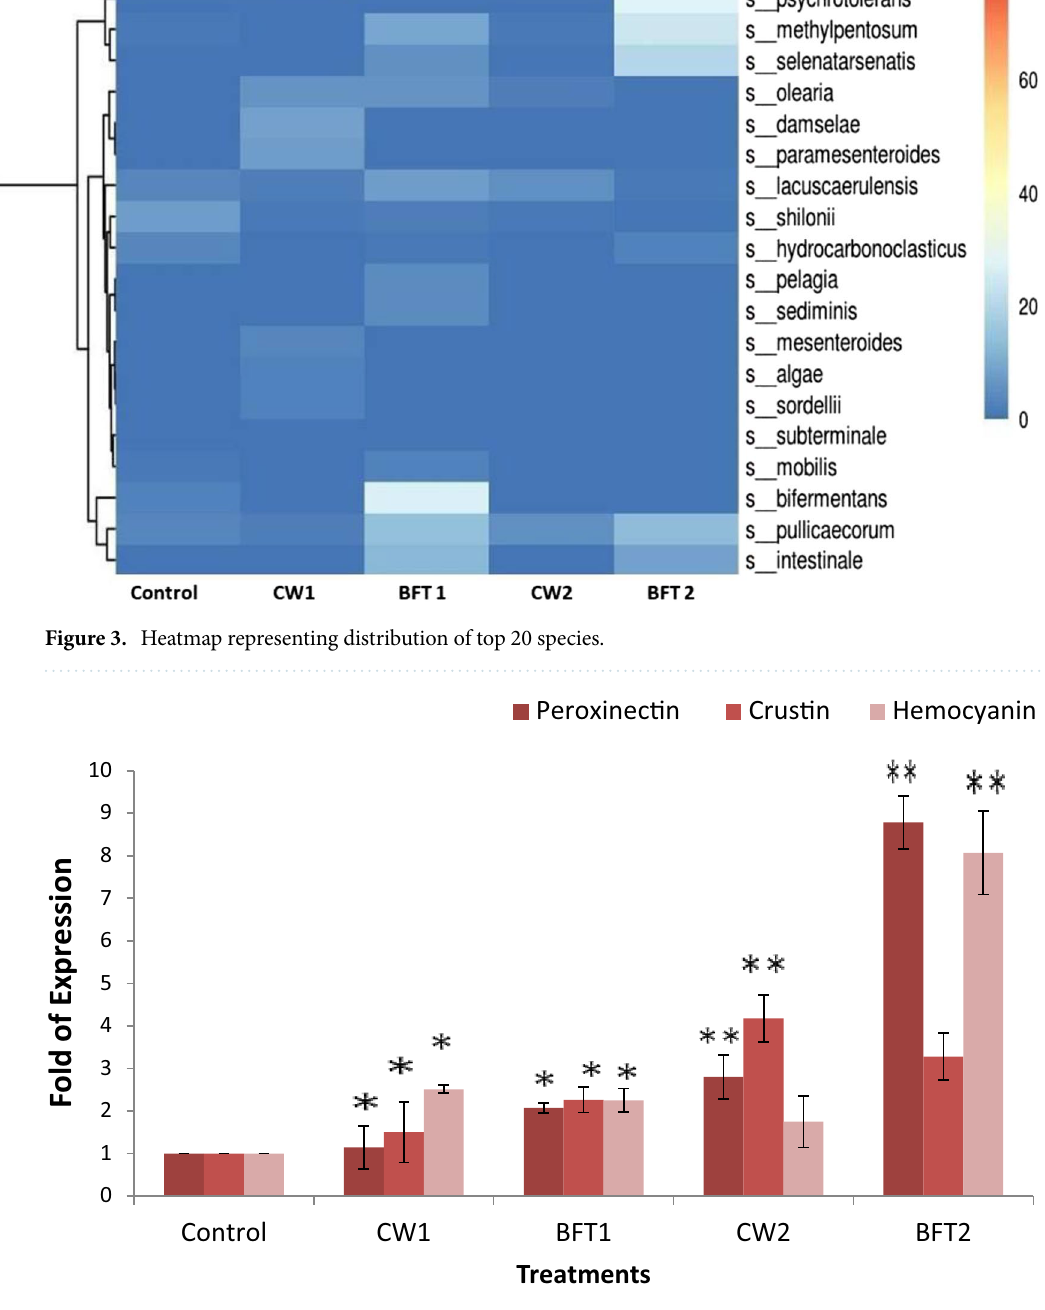
Figure 4. Relative expression of peroxinectin, crustin and hemocyanin of P. indicus cultured in different treatments and error bar showing standard deviation of three replicates. Significance between different groups ( P < 0.05) marked with asterisk